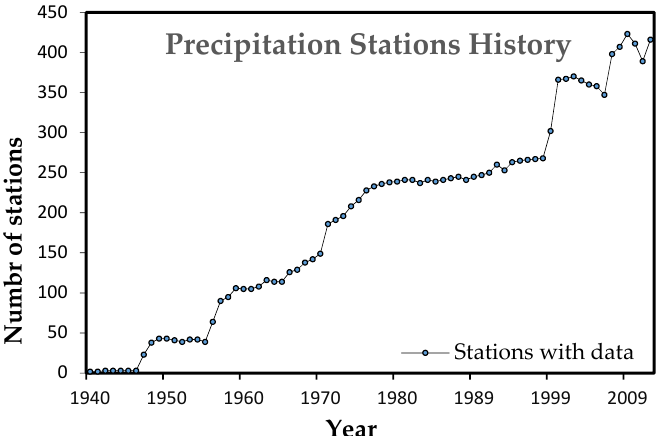
Figure 2. The number of precipitation gauges and their age in the Department of Hydrology and Meteorology (DHM) database.